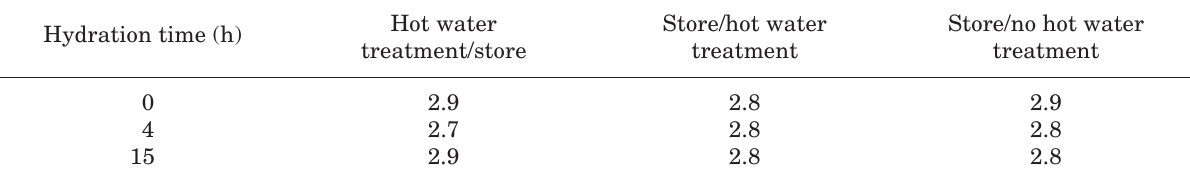
Table 3. Cultivar Chardonnay - means of final condition scores where 1, dead; 2, “B” grade; 3, “A” grade. Hydration time